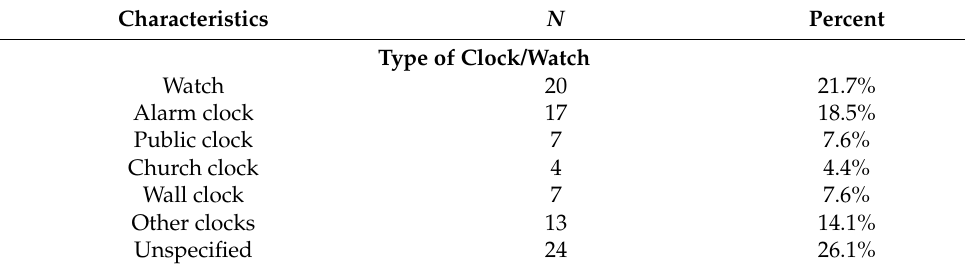
Table 1. Characteristics of the dreams with clocks/watches ( N =